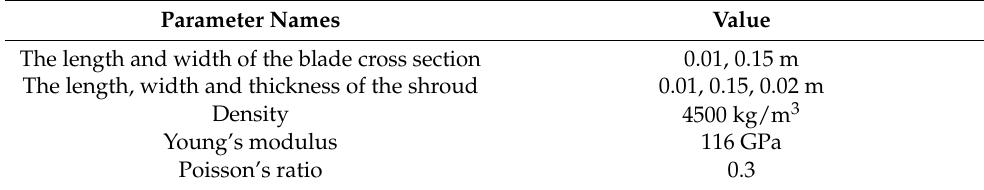
Table A2. Gross parameters of the finite element